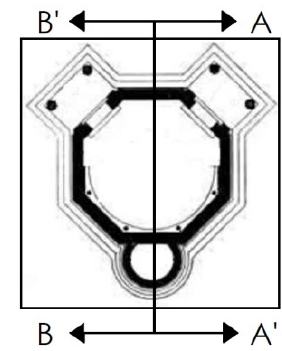
Figure 5: Example of the position of two of the vertical cross section plans of North-South (A-A’) and South- North (B-B’)